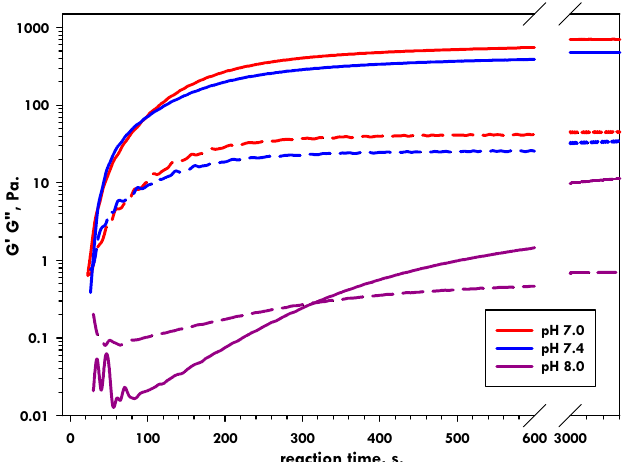
Figure 9. Rheological measurements of 1% CLEX alginates gels at the indicated pH. Solid lines = G’, dashed lines = G’’. (Data originally reported in [27]).